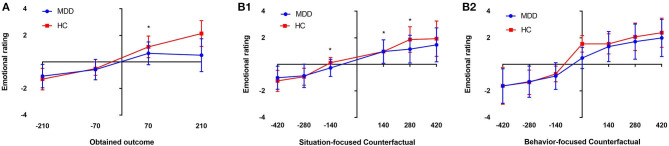
Mean emotion ratings for the four obtained outcomes (−210/−70 and +70/+210). The MDD patients showed weaker positive responses to wins (+70) than the healthy controls (HCs) (*p < 0.05, A). (B1) Shows the situation-focused CT (obtained outcome—unobtained outcome from that wheel) emotion responses for the first rating, followed by the comparison (B1). (B2) Shows the behavior-focused CT (obtained outcome—outcome from the unselected wheel) emotion responses for the second rating, followed by a comparison between choices (B2) (*p < 0.05; NS, non-significant). The emotion scale ranged from−5 (extremely negative) to +5 (extremely positive).